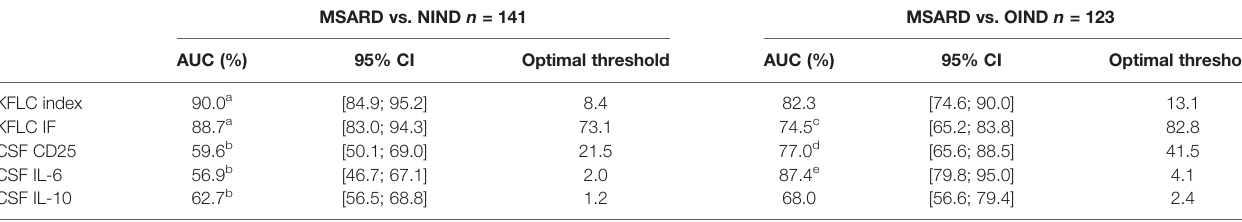
TABLE 2 | Diagnostic performances of the different biomarkers for MSARD diagnosis compared to both control